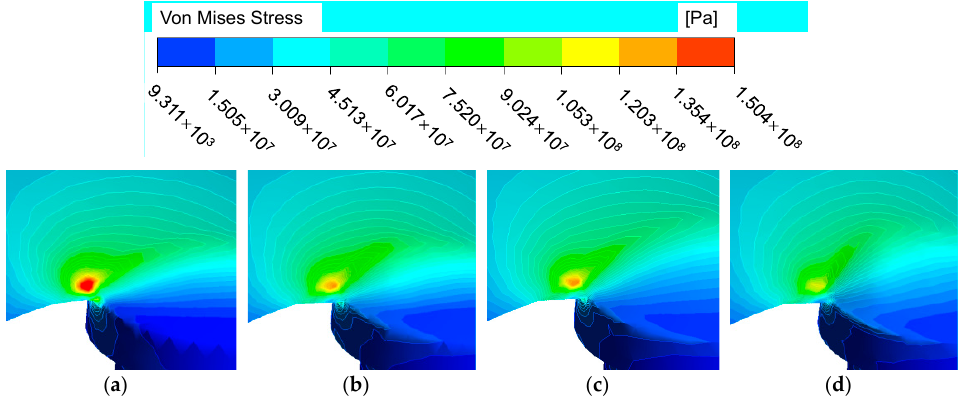
Figure 13. Maximum dynamic stress distribution of blades with different root thicknesses when φ = 66°: ( a ) Model 1, ( b ) Model 2, ( c ) Model 3, and ( d ) Model 4.